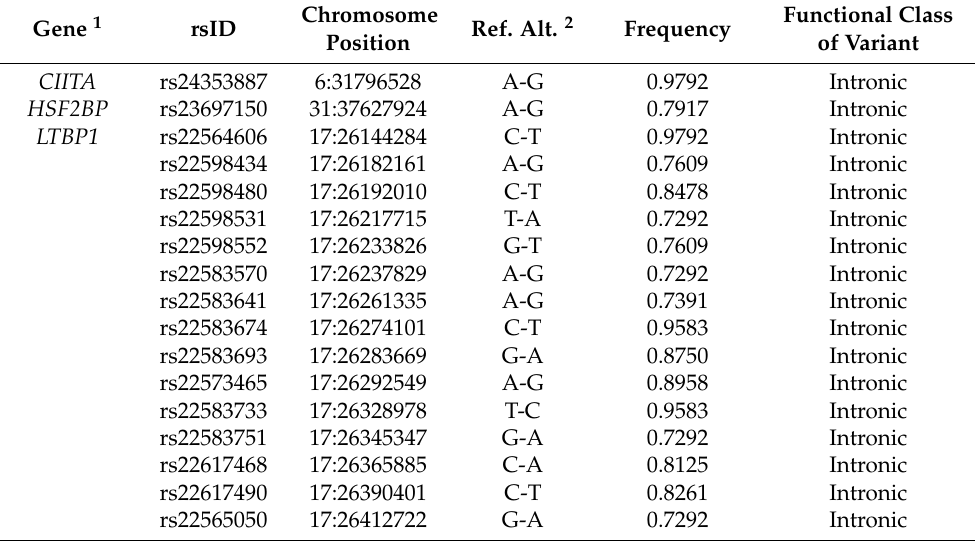
Table 3. Genomic variants, found in genes other than the cytokines analyzed, with a frequency of the alternative allele above 0.7. Table showing the identify number (rsID), chromosome position, reference and alternative alleles, frequency of alternative variant in the analyzed dataset, and functional class of